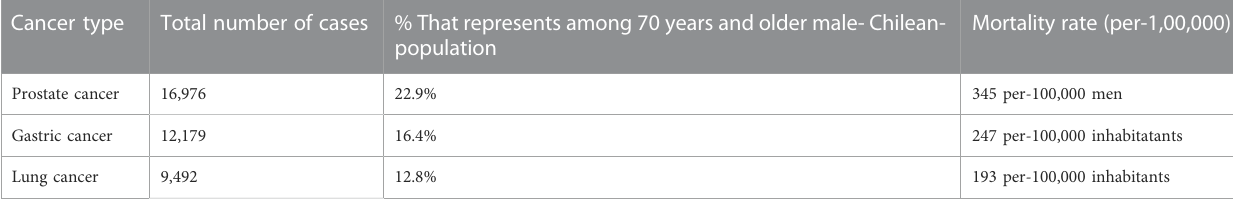
TABLE 1 Main types of malignant tumors excluding non-melanoma skin cancer, total number of cases, percentage representing among 70 years and older population, mortality rate, in Chilean male population during the period 2009 – 2018. Cancer type